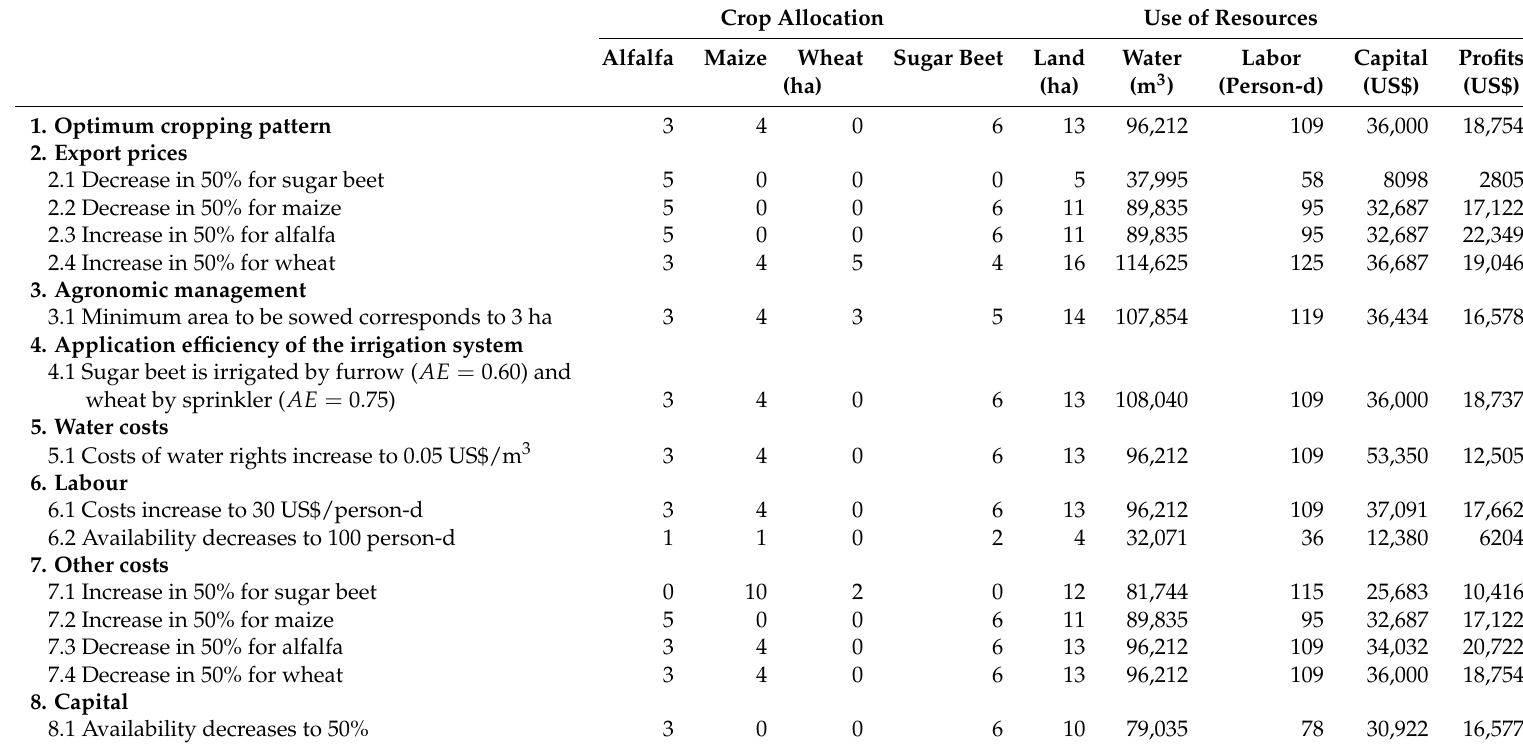
Table 5. Sensitivity analysis for scenario 6, situation